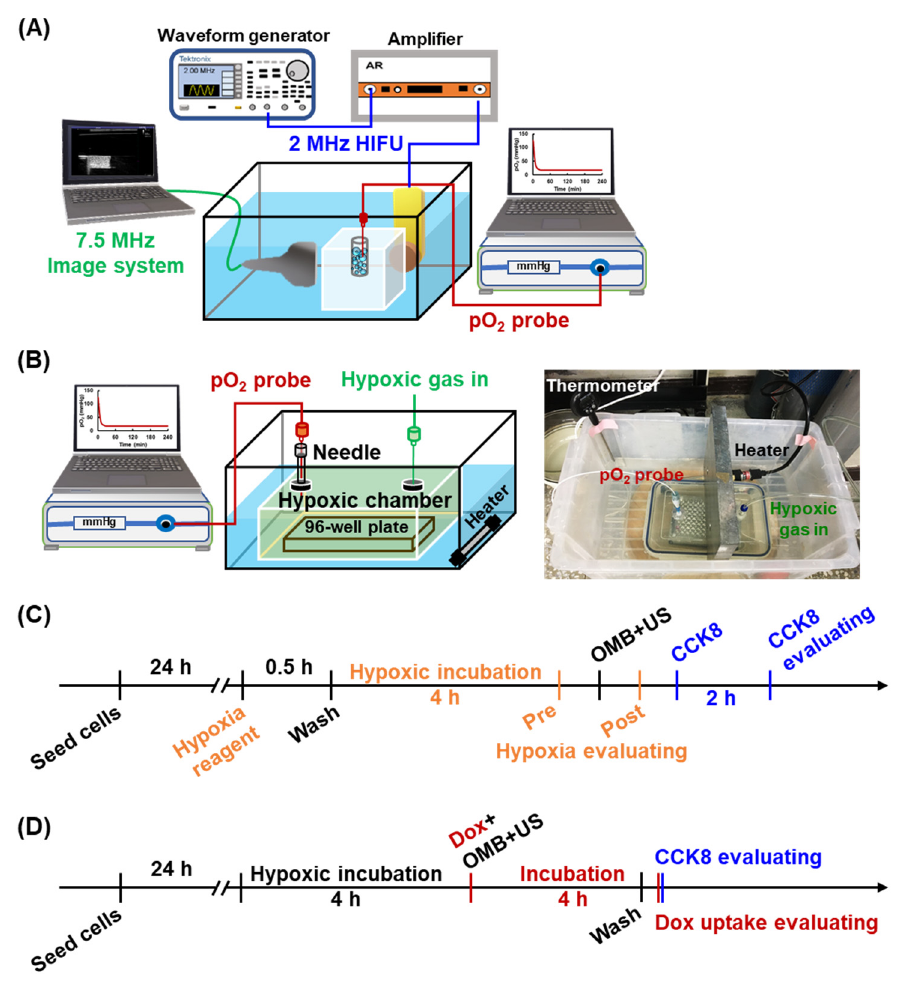
Figure 2. The experimental set up of ( A ) the integrated platform including a 7.5 MHz US imaging system, a 2-MHz HIFU sonication system, and a pO 2 detection system and ( B ) the home-made hypoxic chamber for generation of the HDR cell model. Flow chart of in vitro cell experiments for ( C ) evaluation of reoxygenation and ( D ) effect of OMB treatment on HDR.